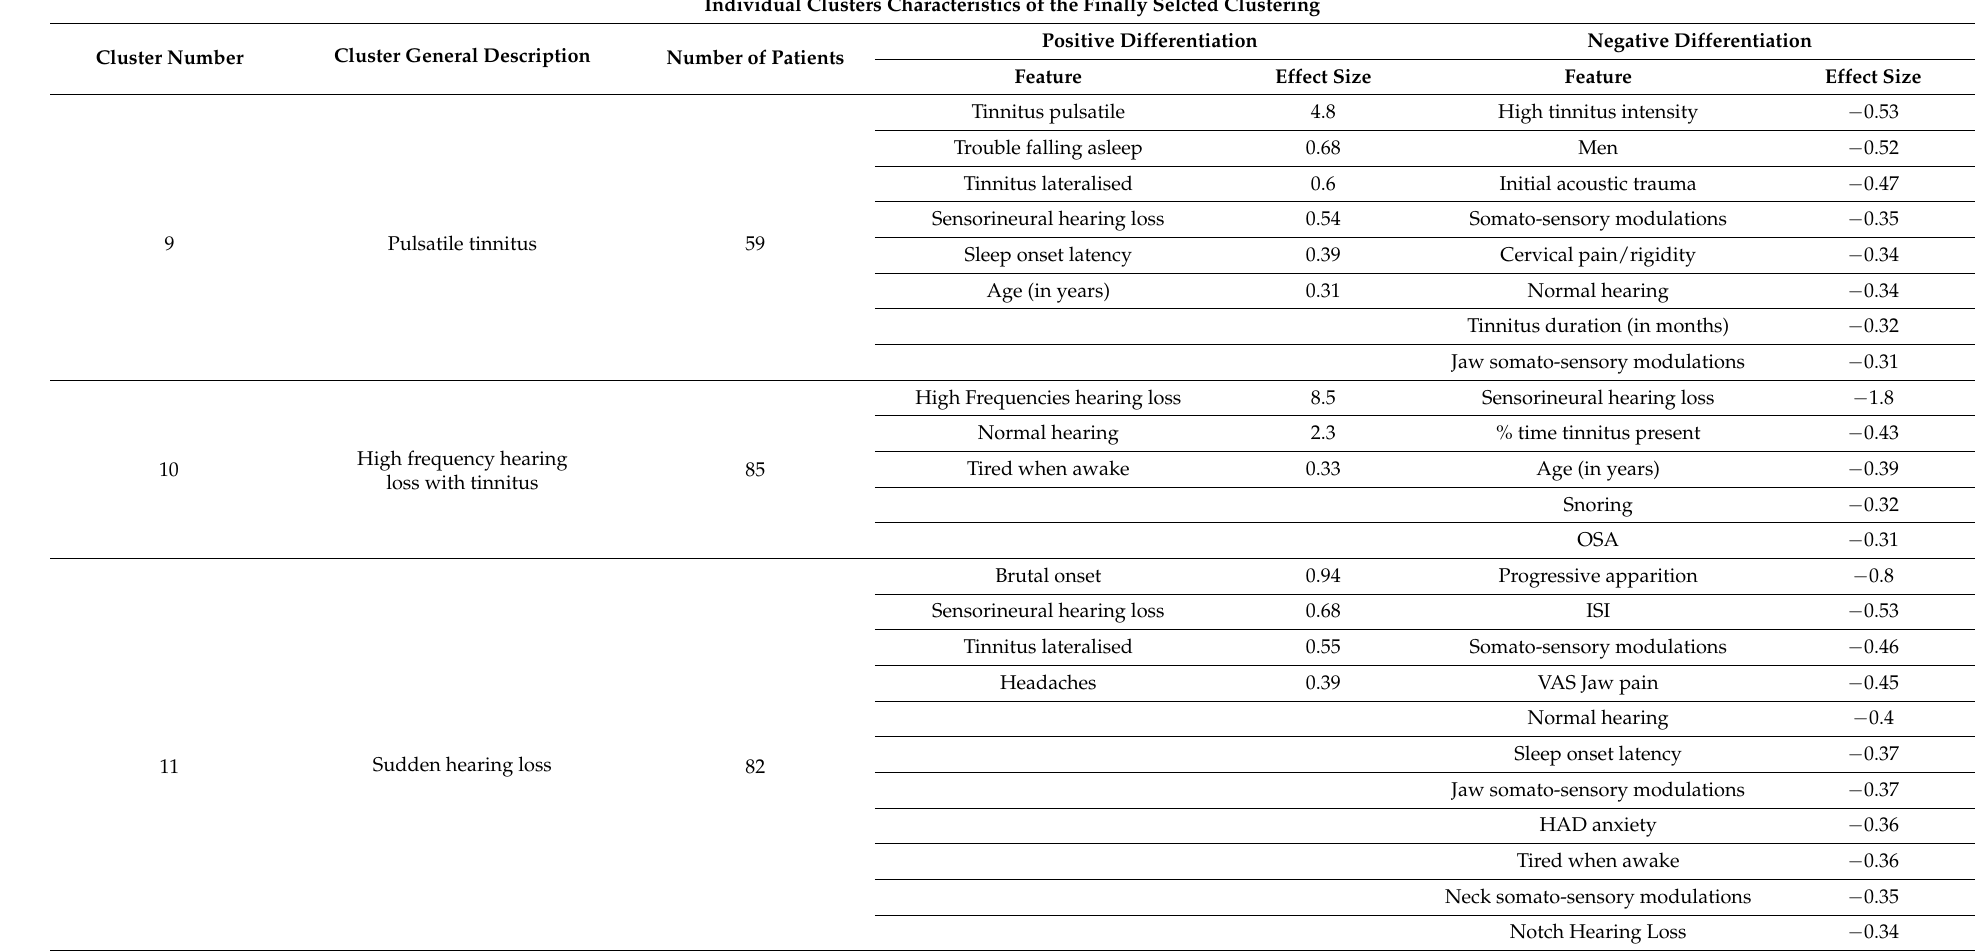
Individual Clusters Characteristics of the Finally Selcted